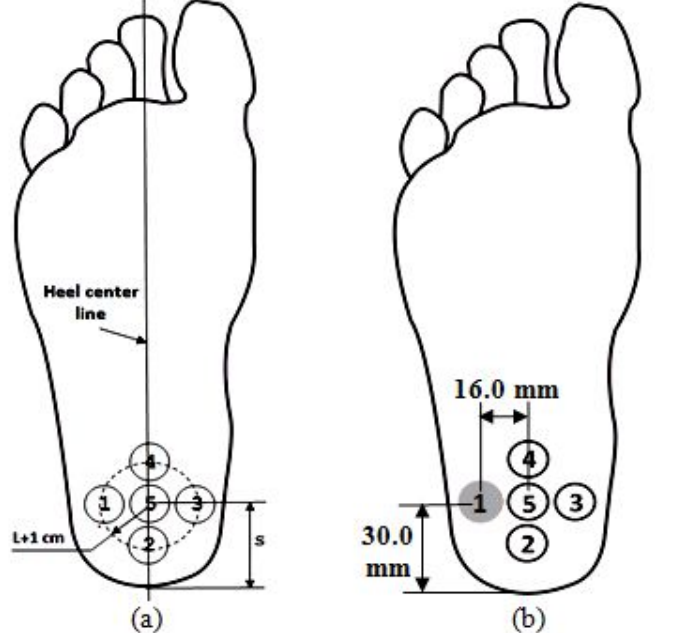
Figure 8. Soft shoe in-sole insert material in the heel area for volunteer #9: ( a ) Definition and notation; ( b ) The dimensions of the distances for soft material laying.